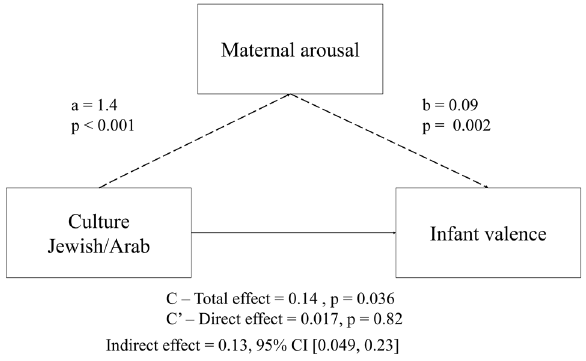
Figure 2. Maternal arousal mediates the association between culture and infants’